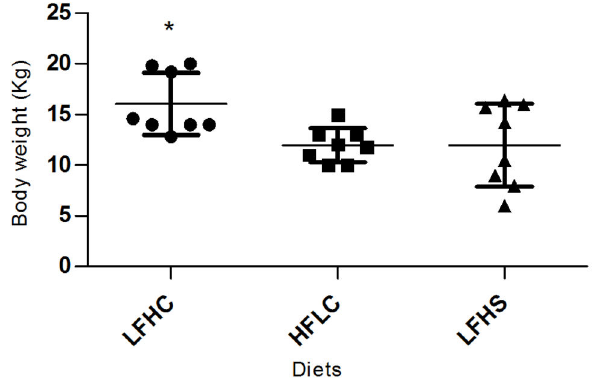
Figure 7. Body weight (kg) of minipigs by the end of the study. Low fat, high carbohydrate (LFHC); high fat/cholesterol, low carbohydrate (HFLC); low fat, high carbohydrate/sucrose (LFHS). * p < 0.05.